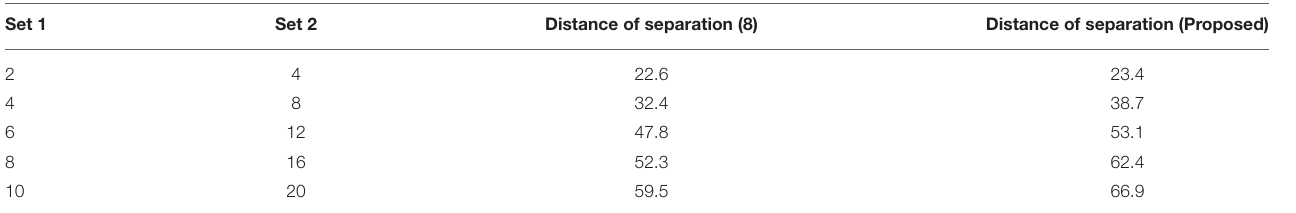
TABLE 3 | Distance of